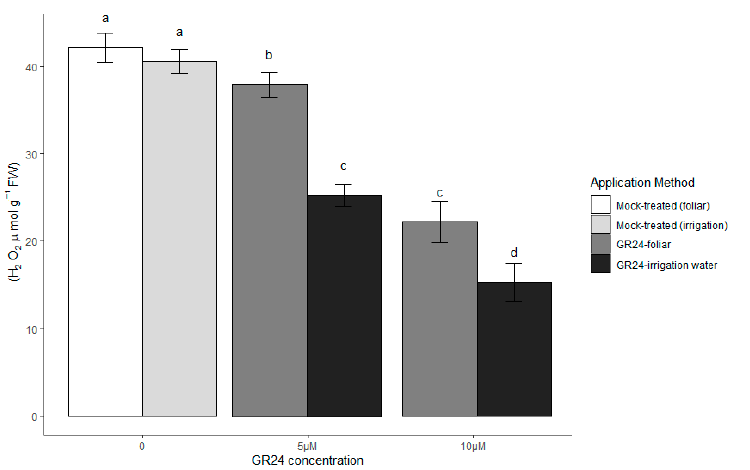
Figure 3. H 2 O 2 in wheat plants in response to two methods of GR24 application under drought stress conditions. Mock-treated plants in these graphs were equally drought-stressed but received a water and acetone solution; for irrigated control values, see Supplementary Materials Figure S4. Each value represents the mean ± SE ( n = 4, each replicate the pool of four plants). Different letters on top of bars indicate significantly different means for p ≤ 0.05 (LSD test).